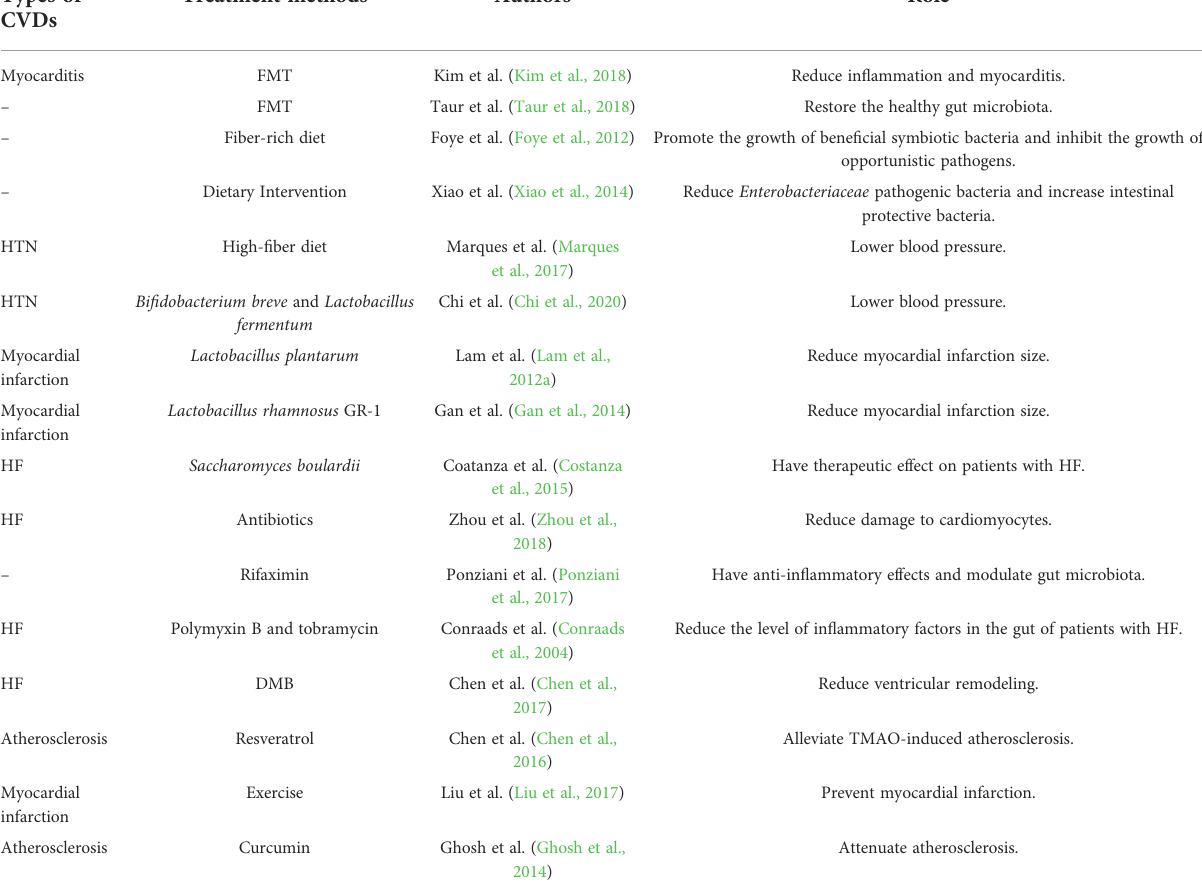
TABLE 2 Microorganism-targeted